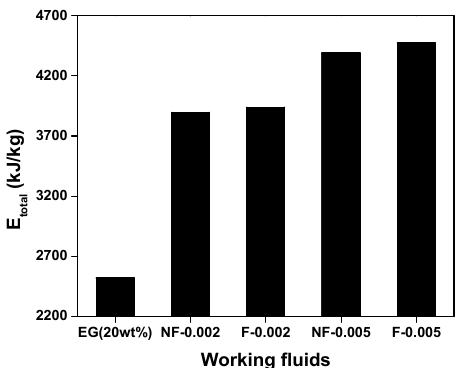
Figure 14. Total stored energy during heating process in function of the weight concentration of functionalized and nonfunctionalized MWCNT nanofluid.